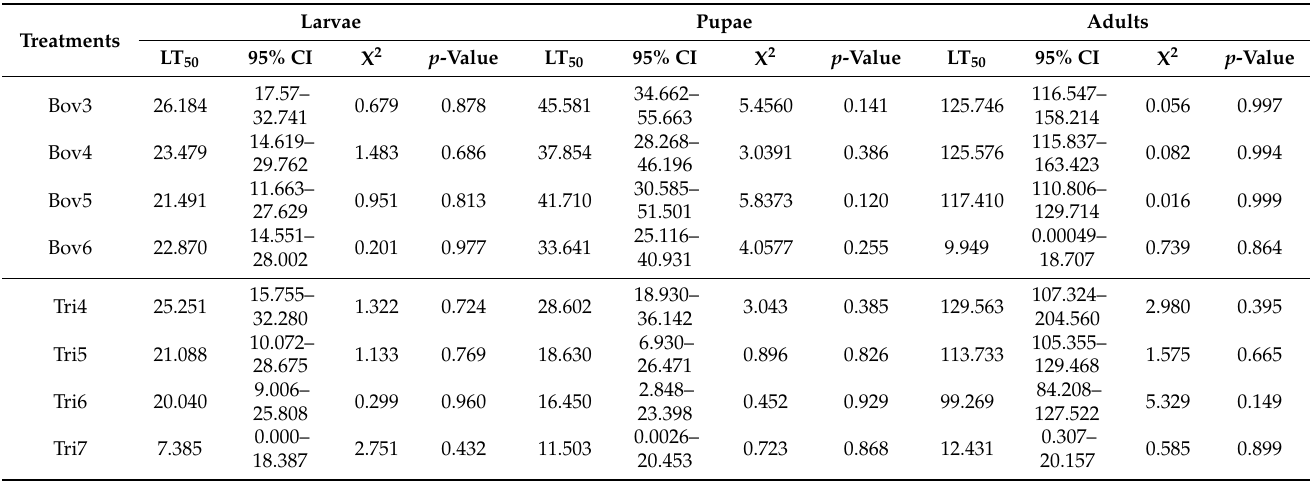
Table 1. Lethal times (LT 50 ) in hours for the entomopathogenic activity of the fungi Beauveria Bassiana and Trichoderma harzianum against Atta sexdens rubropilosa Forel 1908 (Hymenoptera: Formicidae) larvae, pupae and adults (workers) (n = 20).